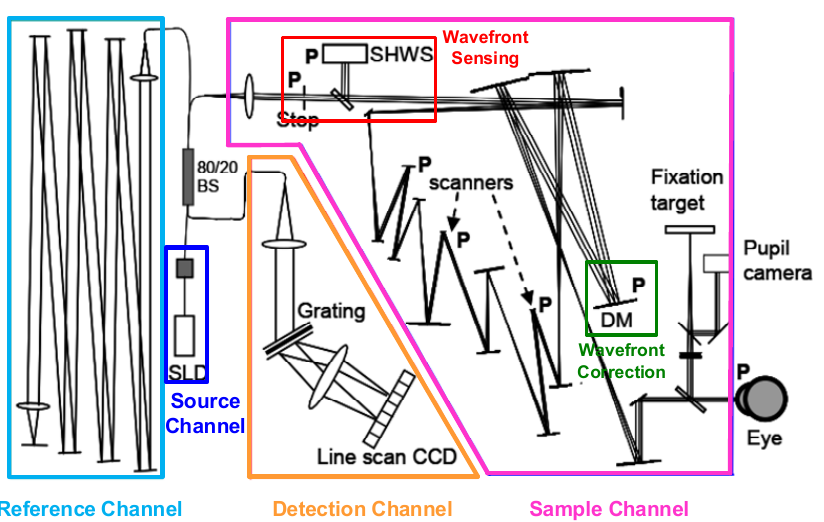
Figure 7. Simplified schematic diagram of a typical AO SD-OCT optical system. BS, DM, and P referred to the fiber beam splitter, AO deformable mirror, and planes that were conjugate to the pupil of the eye, respectively (Reprinted with permission from Ref. [123]. Copyright 2006, Optical Society of America).